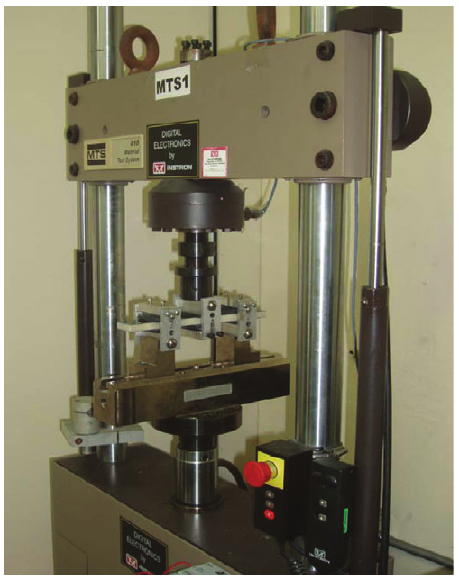
Figure 6 Testing setup used in TPB.